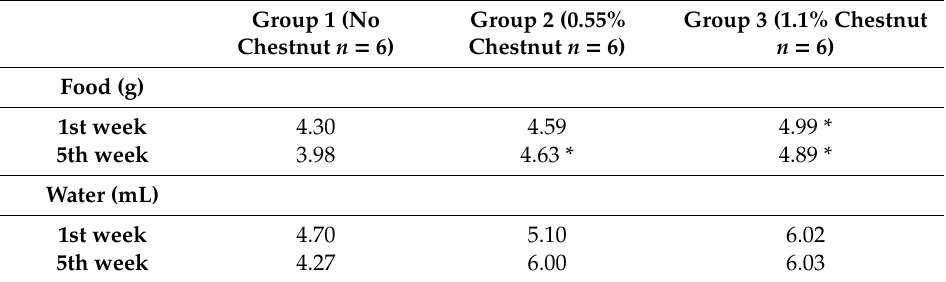
Table 2. Mean daily food and water consumption per animal at experimental weeks 1 and